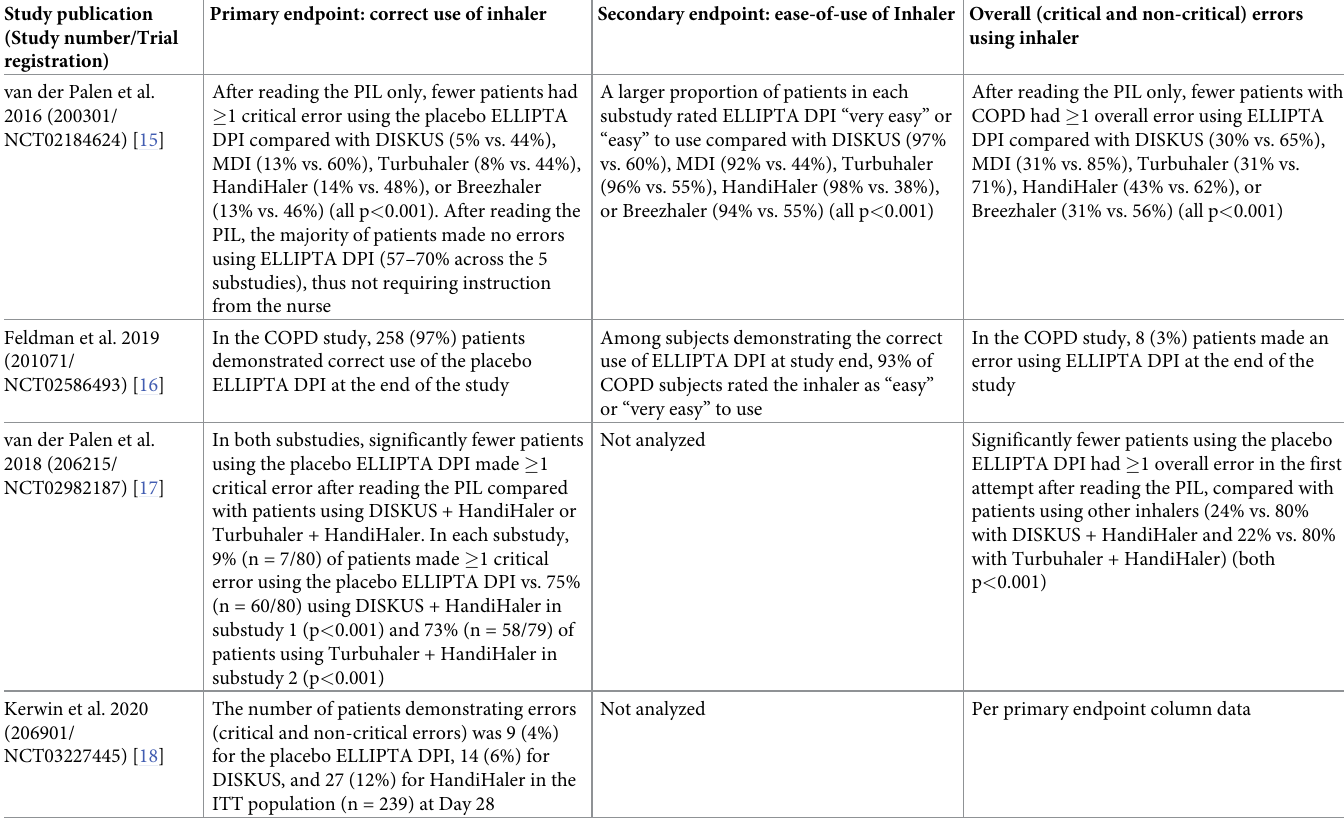
Table 3. Efficacy outcomes for individual studies.